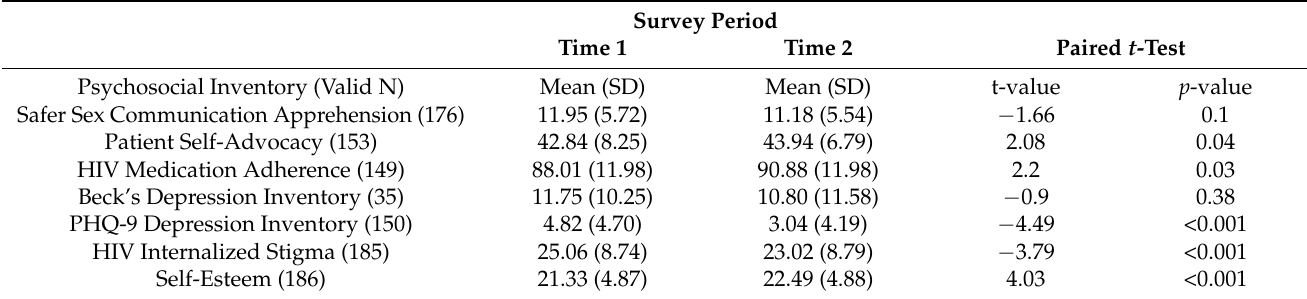
Table 5. Change in psychosocial inventories for individuals who completed the PREP training, paired t